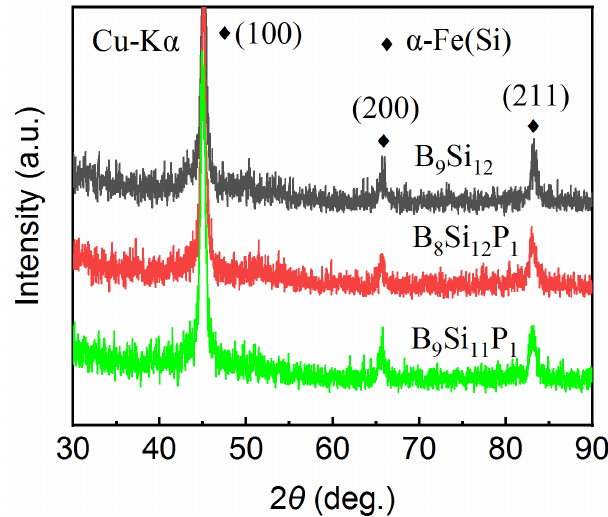
Figure 6. XRD patterns of B 9 Si 12 , B 8 Si 12 P 1 and B 9 Si 11 P 1 ribbons annealed at 550 °C for 60 min.